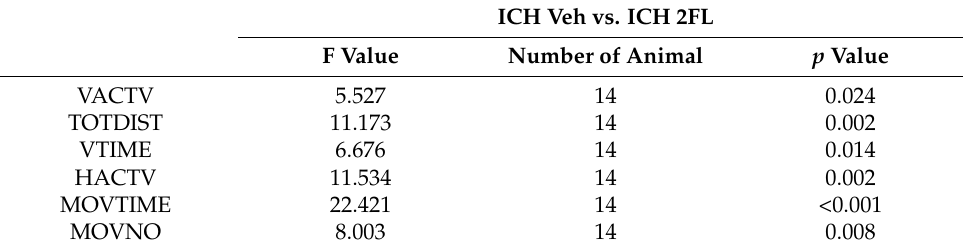
Figure 2. Post-treatment with 2FL improves neural functions in ICH rats. Adult rats were treated with type VII collagenase on D0 ( G , timeline). 2FL or vehicle was given systemically daily for 5 days. Locomotor behavior was examined on D5. 2FL significantly improved ( A ) vertical activity, ( B ) total distance traveled, ( C ) vertical time, ( D ) horizontal activity, ( E ) movement time, and ( F ) movement number. n = 7 in each group. * p < 0.05, two-way ANOVA; # p < 0.05, post hoc NK test. Table 1. Significant differences in locomotor behaviors between ICH +veh and ICH